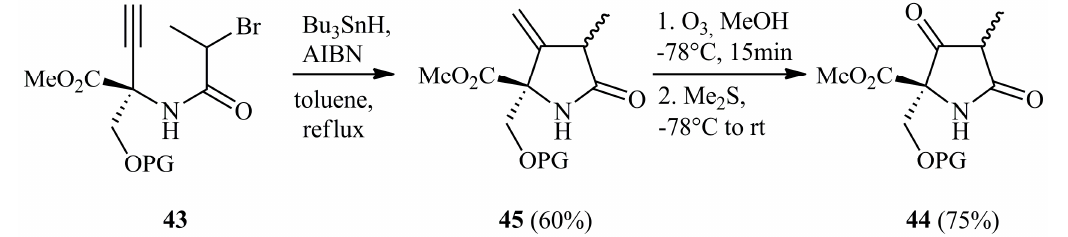
Scheme 12. Pattenden’s radical approach to 3 ‐ methyl tetramic acids 44 .